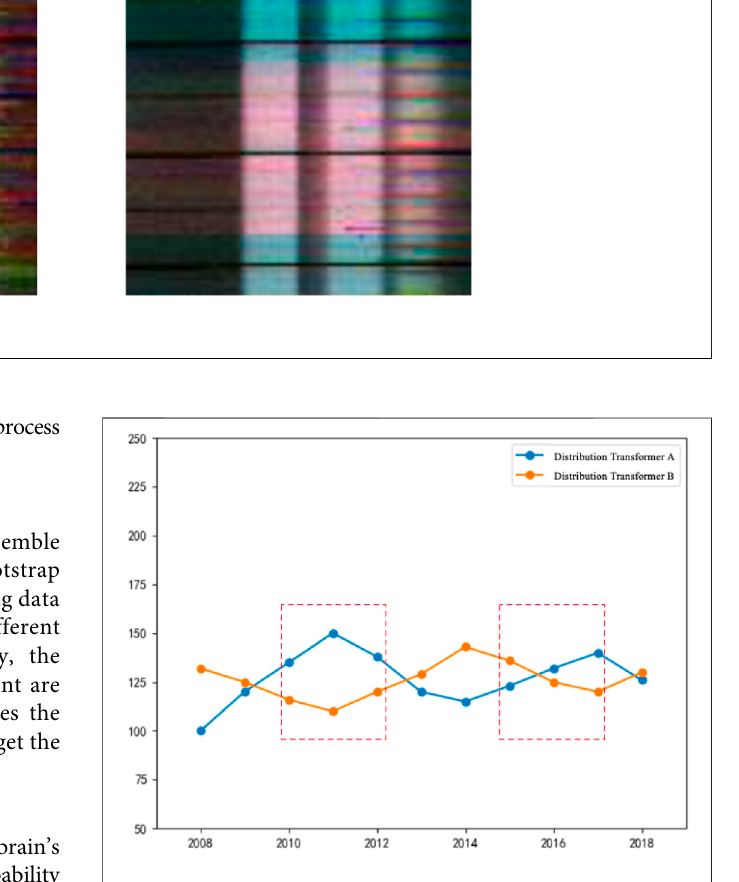
FIGURE 4 | Schematic diagram of Load Trend